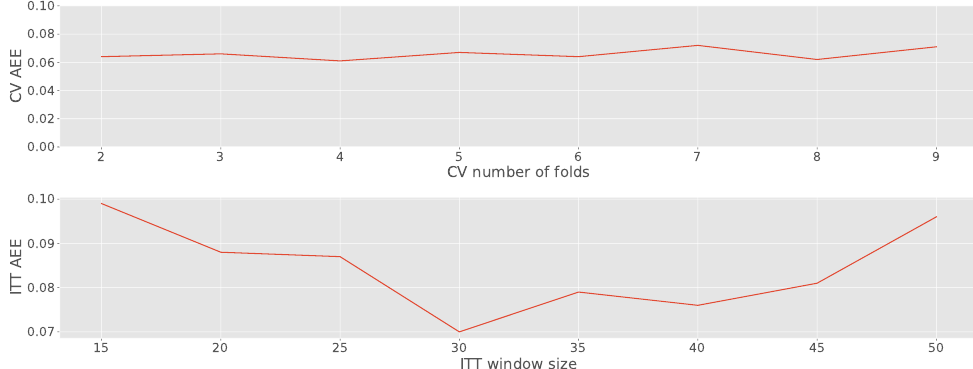
Figure 7. Evaluation of different parameters for cross-validation (CV) and interleaved test/train error (ITT) for GLVQ classifier on the OUTDOOR data set.